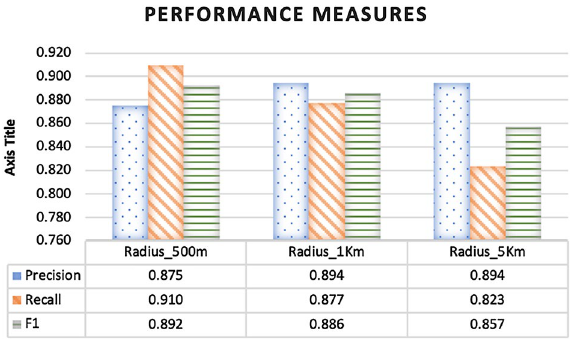
Fig. 10 Effect of varying the event clustering radius on the performance measures: Precision, Recall and F1